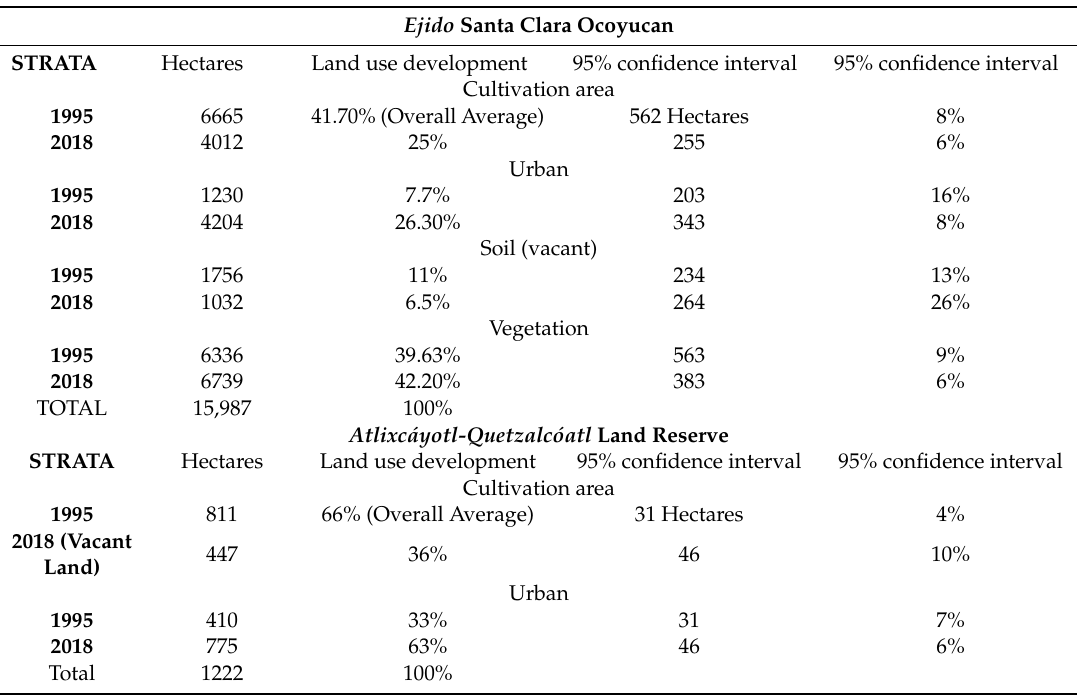
Table 4. Sampling Size calculation for the case study areas according to Olofsson’s method.